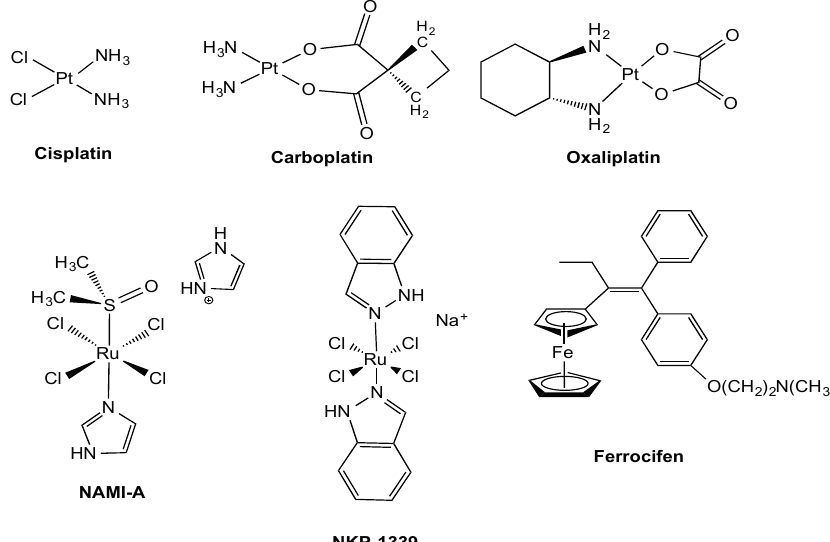
Figure 1. Chemical structures of clinical and experimental metal-based anticancer